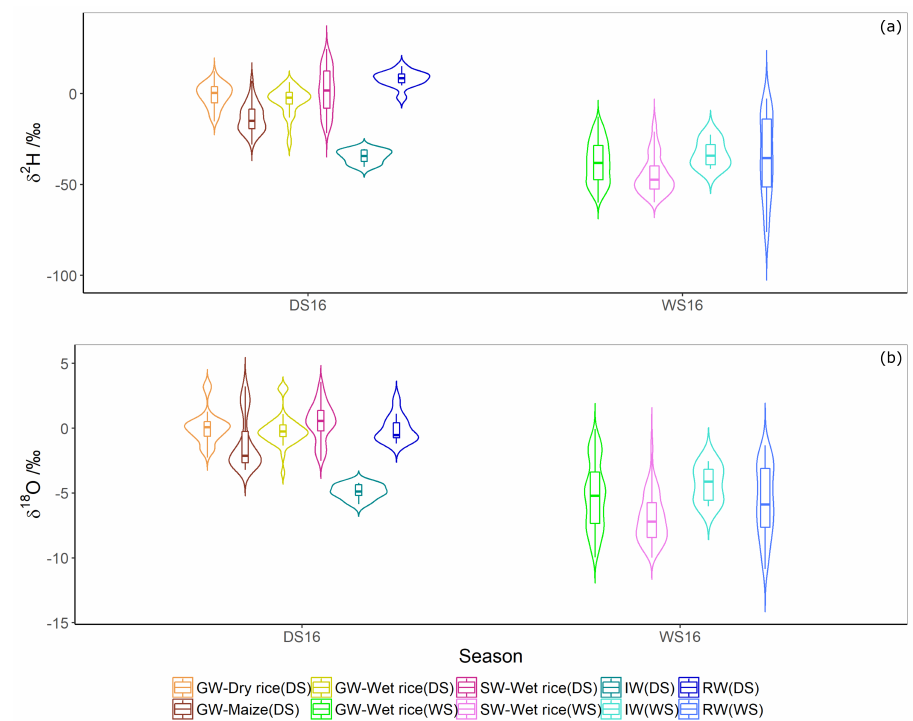
Figure 5. Violin plots of isotope values for δ 2 H ( a ) and δ 18 O ( b ) of groundwater (GW) and surface water (SW) from different crops (maize, wet rice, and dry rice), rainwater (RW) and irrigation water (IW), and during dry season (DS) and wet season (WS).